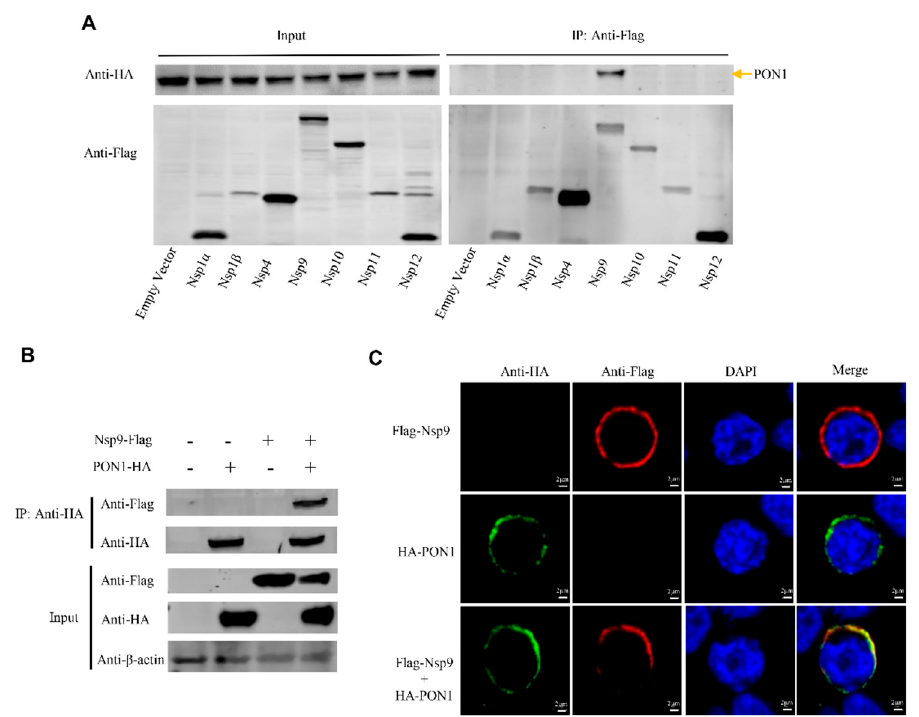
Figure 4. PON1 interacts with the Nsp9 of PRRSV. ( A ) Selection of the interaction of Flag-tagged PRRSV Nsps with HA-tagged PON1. ( B ) The HA-PON1 interacts with Flag-Nsp9. ( C ) Co-localization of PON1 and Nsp9. HEK-293T cells were co-transfected with HA-PON1 and Flag-Nsp9 plasmids. Cells were fixed and detected by mouse anti-HA mAb (green) and rabbit anti-Flag mAb (red). The nucleus is indicated by DAPI staining (blue).